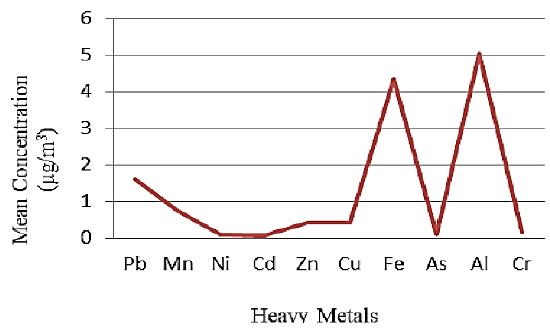
Fig. 4. Mean concentrations of heavy metals in indoor stations